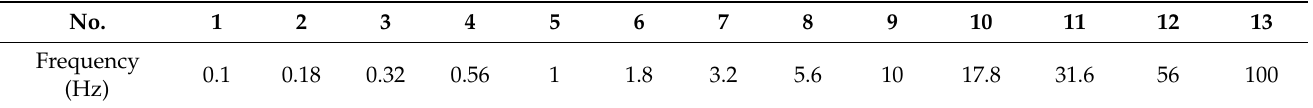
Table 2. Excitation frequency table for tensile mode DMA experiments.